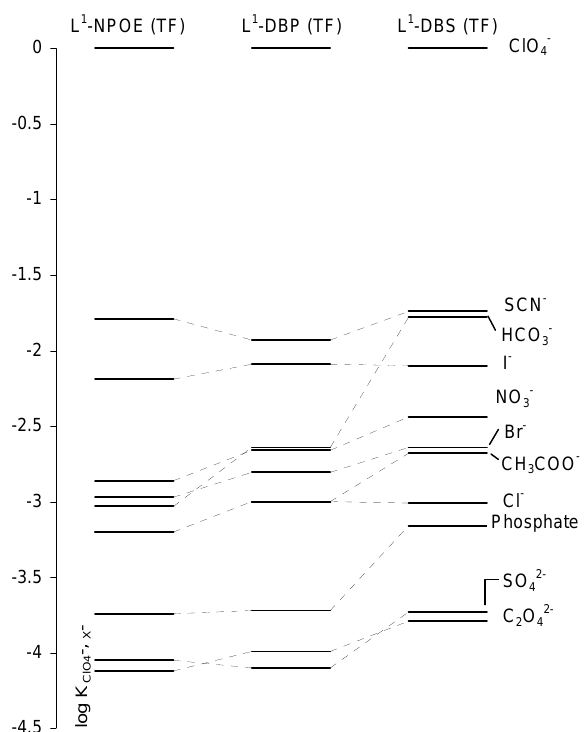
Figure 4. Potentiometric anion selectivity coefficients of electrodes containing the ionophore L 1